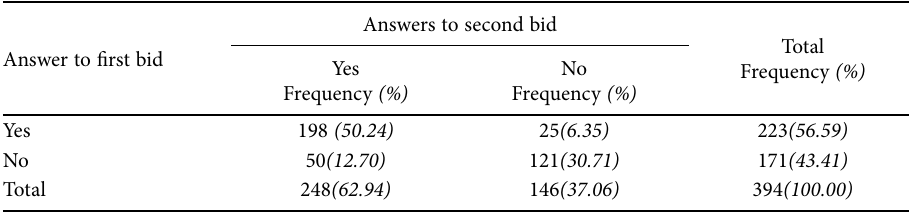
Table 4. Traditional poultry farmers’ responses to double bids.